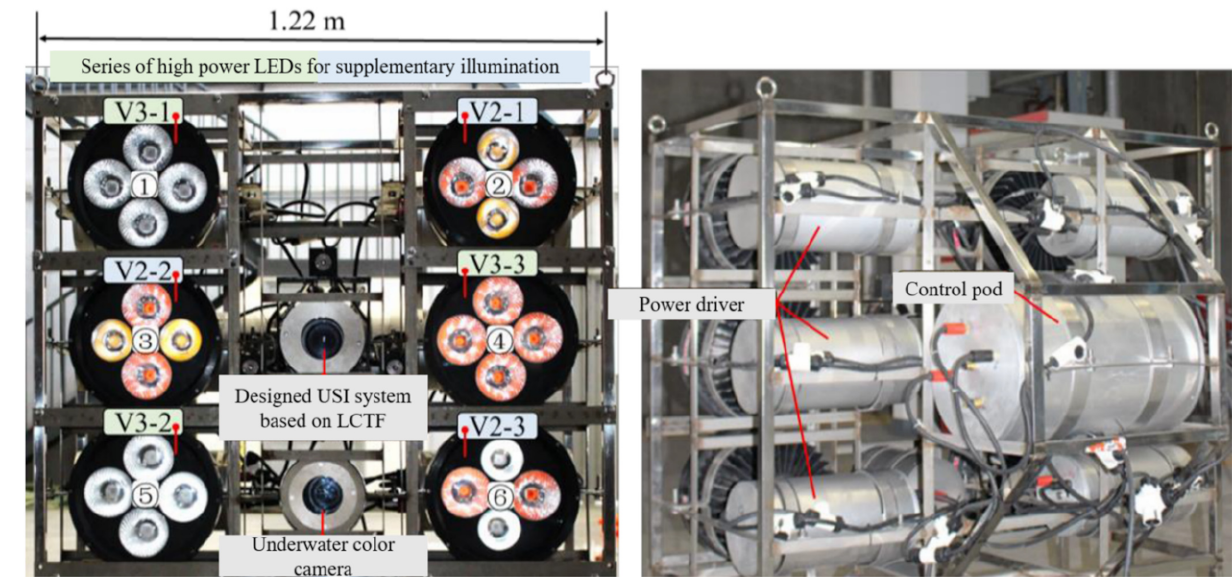
Figure A3. Complete composition of USI system and high-power LEDs light source for underwater